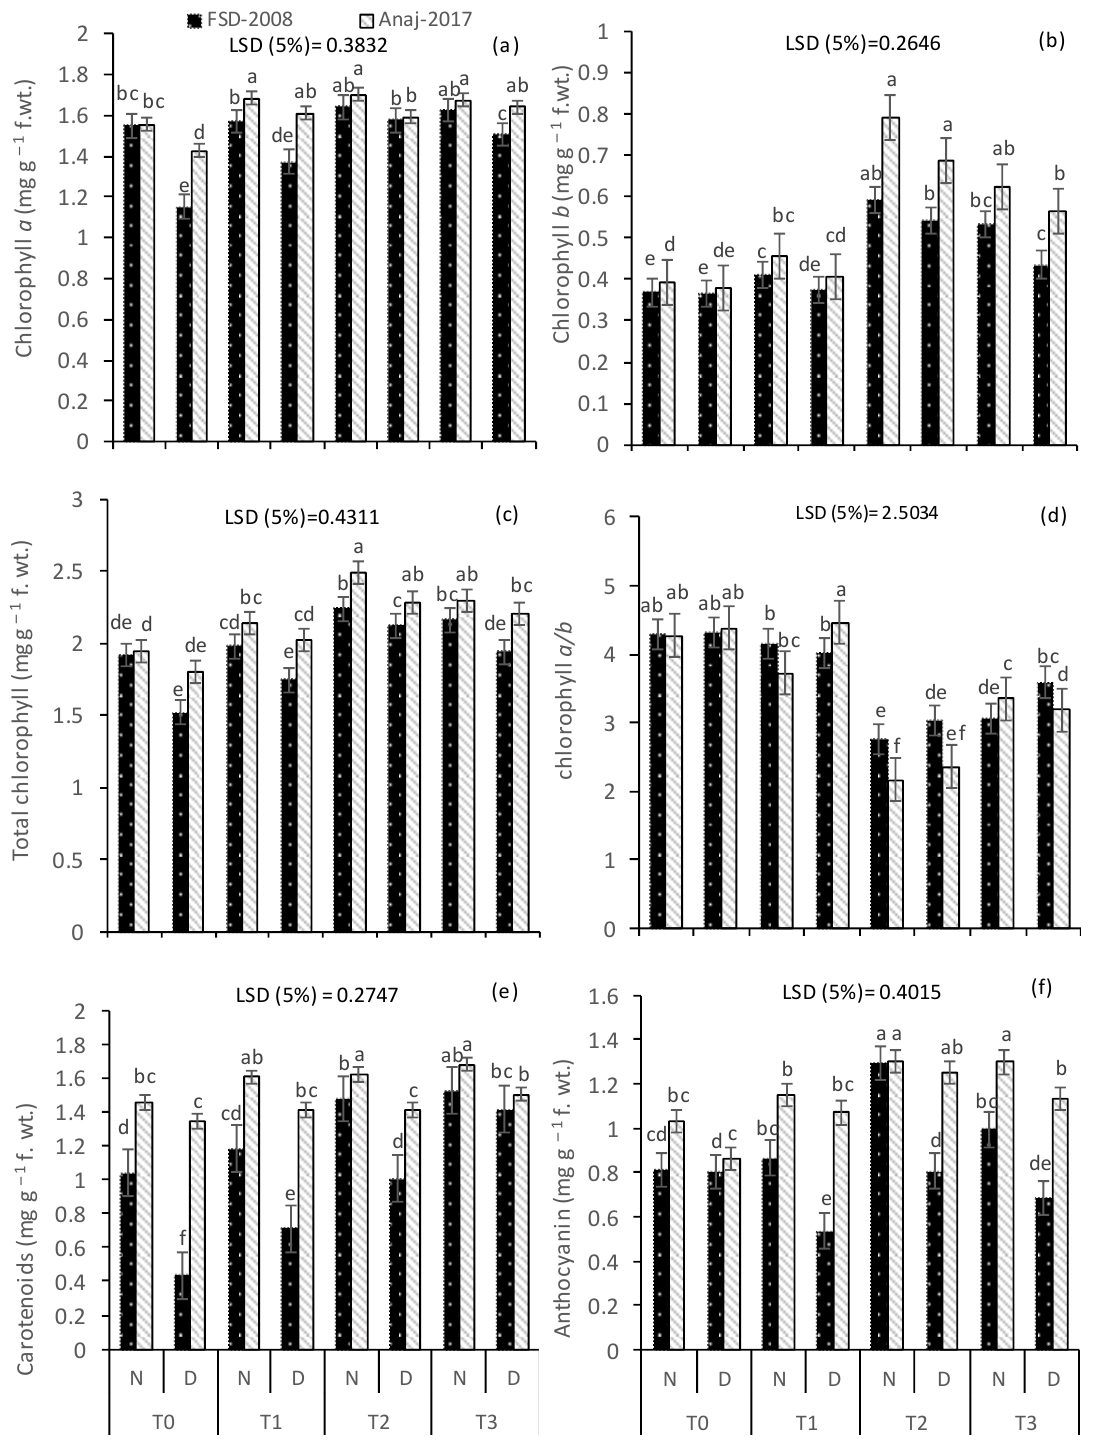
Figure 4. Effects of laser seed priming on ( a ) chlorophyll a , ( b ) chlorophyll b , ( c ) total chlorophyll, ( d ) chlorophyll a / b , ( e ) carotenoids and ( f ) anthocyanin in wheat under drought stress. Legend: N = Control (100% field capacity), D = Drought (50% field capacity), T0 = Unprimed control, T1 = 1 min laser priming, T2 = 2 min laser priming and T3 = 5 min laser priming. Means sharing same lowercase letters on bars are statistically non−significant at P ≤ 0.05%)